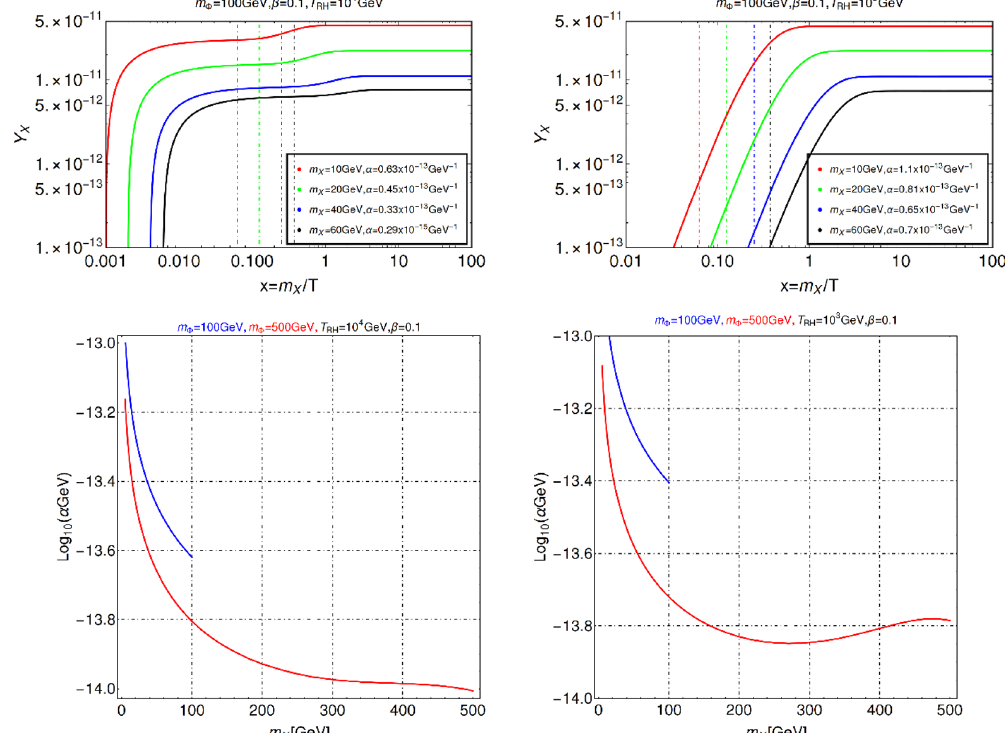
Figure 10 . Top left: DM yield as a function of x = m X /T for a reheat temperature T RH = 10 TeV considering both annihilation and decay to be active before EWSB, while keeping only decay after EWSB. We choose m Φ = 100 GeV and β = 0 . 1 while for each value of m X , α is adjusted to reproduce the central value of the measured relic abundance. Top right: same as top left but with T RH = 1 TeV. In both of the plots the vertical dashed lines denote EWSB ( x EW ). Bottom left: relic density allowed parameter space in m X − α plane for T RH = 10 TeV and α adjusted to reproduce the DM abundance. Bottom right: same as bottom left but with T RH = 1 TeV